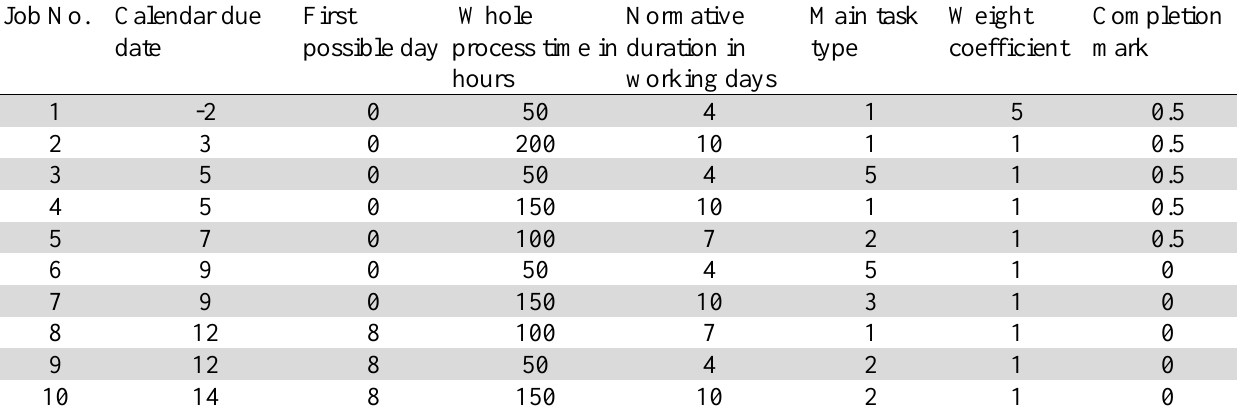
Fragment of main data on jobs Job